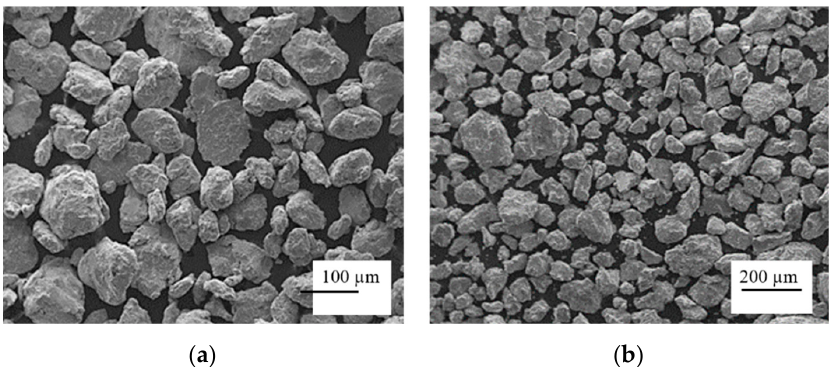
Figure 8. Photomicrograph of stainless steel powders: ( a ) milling at 350 rpm, mass/ball ratio of 1/10, milling time of 50 h; ( b ) milling at 350 rpm, mass/ball ratio of 1/10, milling time of 50 h with addition milling time of 50 h; ( b ) milling at 350 rpm, mass / ball ratio of 1 / 10, milling time of 50 h with addition of of 3% of vanadium carbide. 3% of vanadium